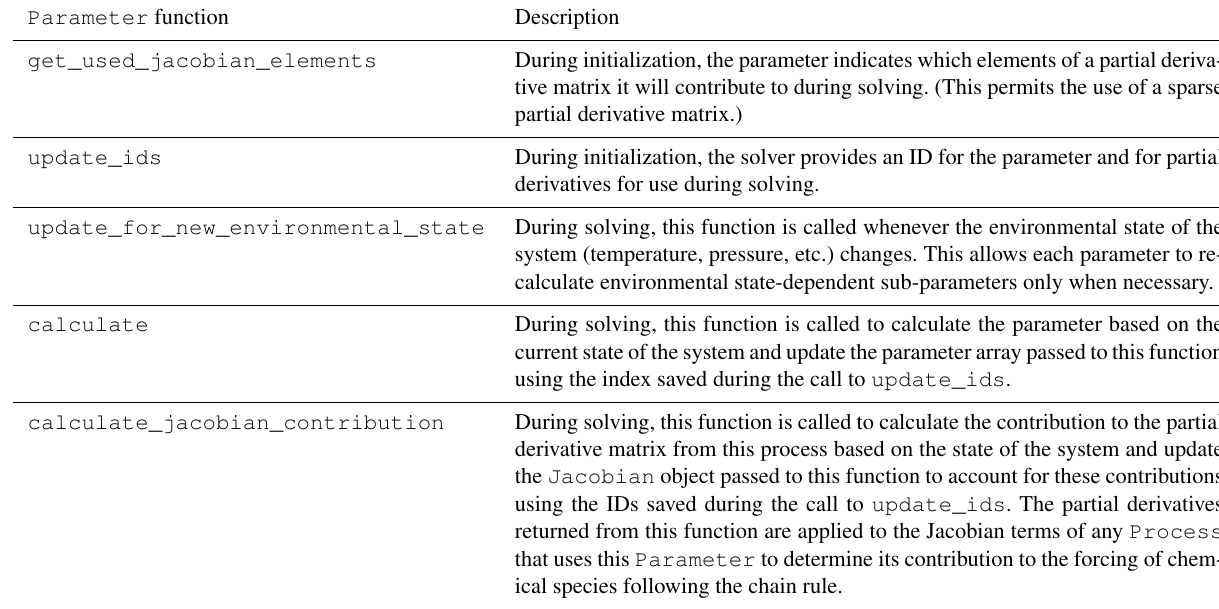
Table 3. Functions of the Parameter base class and its subclasses. Parameter function